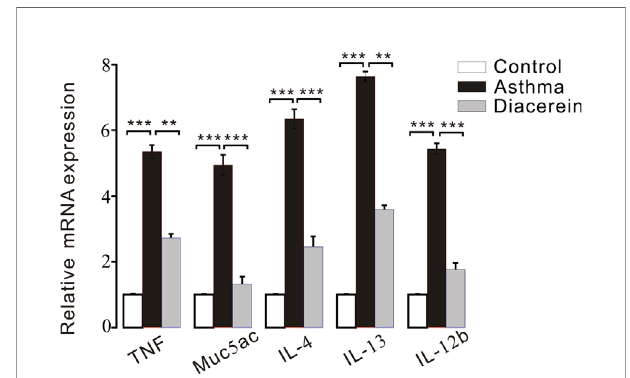
FIGURE 15 | The bar graph showed the different expression levels of tumor necrosis factor (TNF), Muc5ac, interleukin (IL)-4, IL-13, IL-12b in control, asthma, and diacerein groups (n = 5/5 mice). **, p < 0.01; ***, p